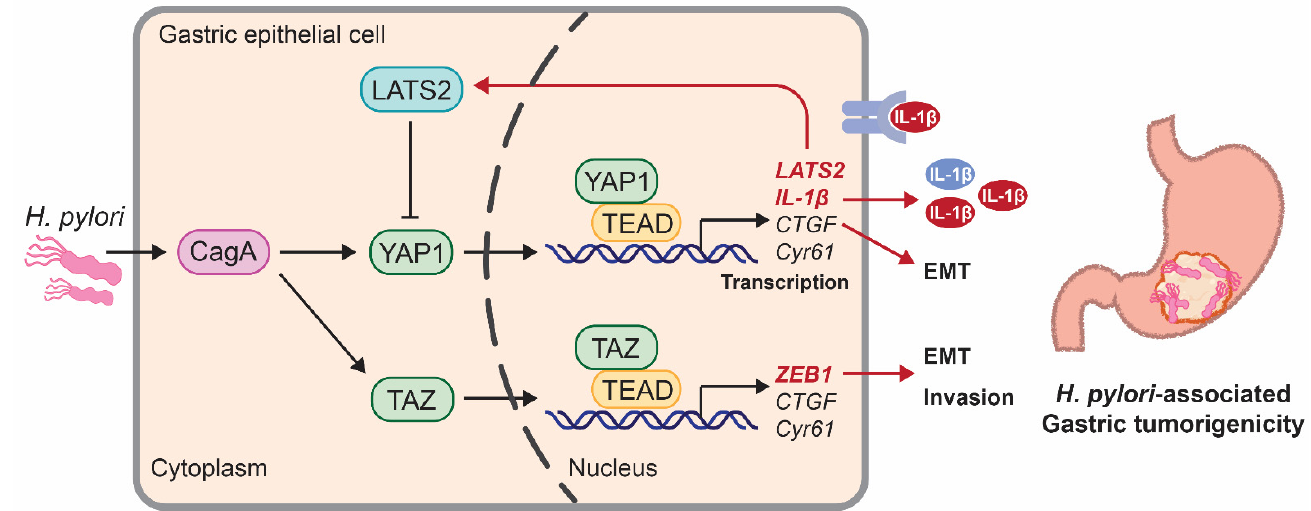
Figure 2. The role of H. pylori in Hippo pathway remodeling. CagA-positive H. pylori infection activates YAP1 and TAZ. CagA promoted the nuclear YAP1 and TAZ levels inside gastric mucosa from gastritis, and intestinal metaplasia, to GC. The Hippo signature genes, such as CTGF, Cyr61, IL-1 β ( Interleukin-1 β ), LATS2, etc., are upregulated following H. pylori infection. Moreover, TAZ participates in H. pylori -driven EMT and gastric carcinogenesis. In the gastric mucosa of H. pylori -associated GC mouse models and patients, nuclear TAZ accumulation activated ZEB1 expression, potentiating the EMT and stemness.